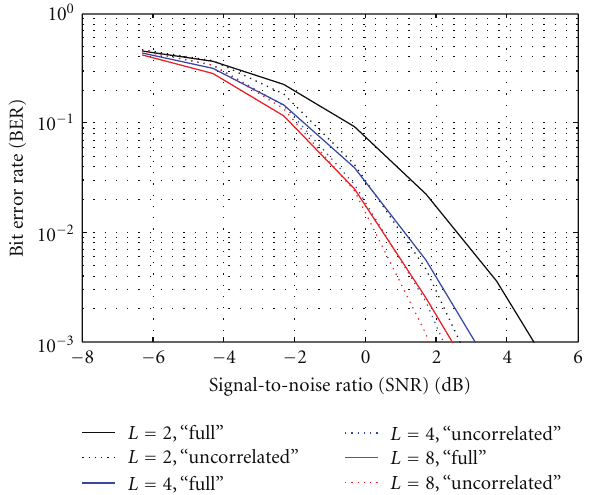
Figure 5: BER performance between di ff erent codebook sizes (full feedback MU-MIMO).